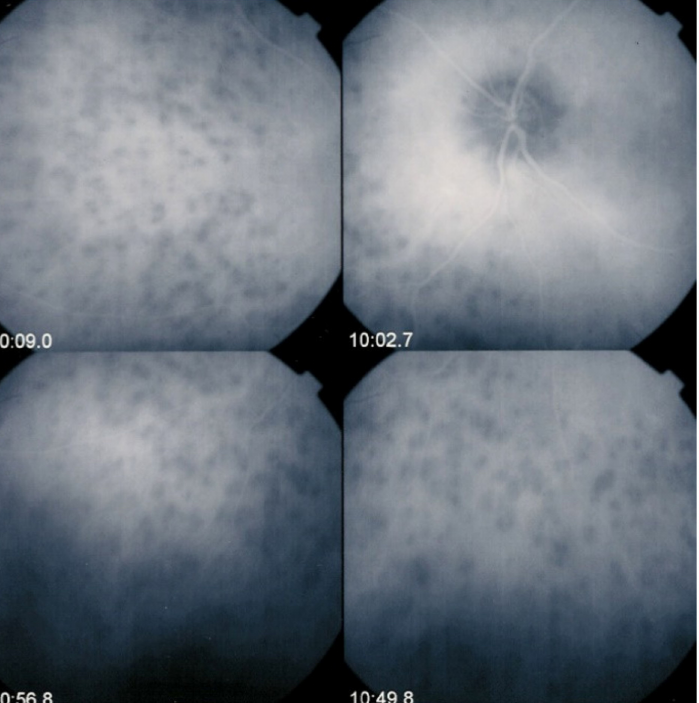
Figure 5. Indocyanine green angiography (ICGA), type 2 pattern found in stromal choroiditis. Typical round HDDs of similar size, evenly distributed caused by the presence of inflammatory foci that impair the diffusion of the ICG dye showing granulomas in negative in case of Vogt-Koyanagi-Harada disease